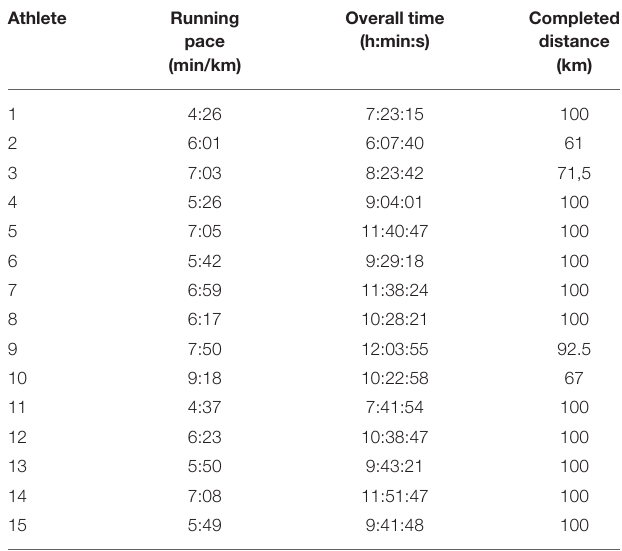
TABLE 1 | Table 1 Race performance of the subjects. Athlete Running pace